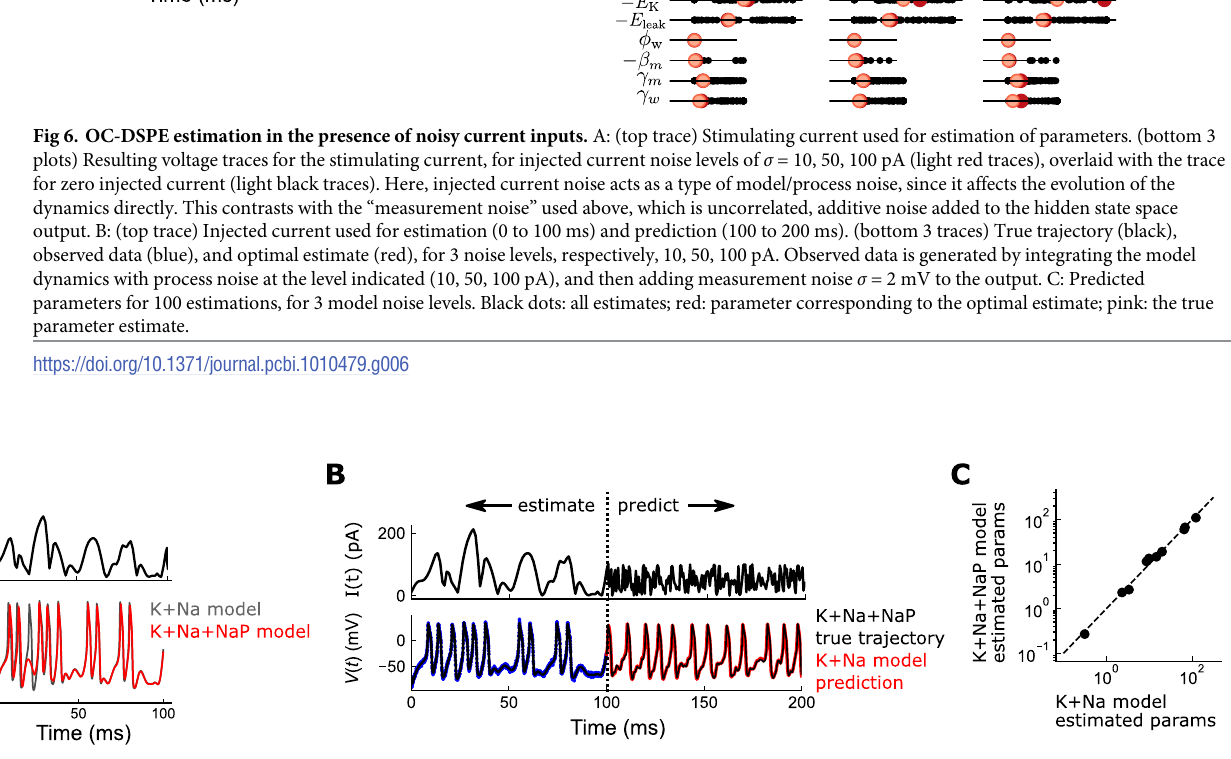
Fig 7. OC-DSPE performance with an under-specified neuron model. A: Injected current (top) and resulting membrane voltage (bottom), using the original Morris-Lecar model with Na and K channels (grey), or with an extra NaP channel (red). The addition of the extra channel has appreciable effects on the response, including missing spikes. B: Injected current (top) and optimal OC-DSPE estimated voltage trace (bottom; black) by fitting observations (bottom; blue) from a K+Na +NaP model to an Na+K model. Red: forward predictions of the K+Na model using estimated parameters, overlaid with forward predictions of the true K+Na+NaP model (black). C: The optimal parameters used in B are plotted against the optimal parameters produced by fitting observations without model misspecification (i.e. parameters from Fig 5D–5F). The estimated parameters are nearly in agreement, but small deviations in the optimal fits account for the modified traces that fit the K +Na+NaP